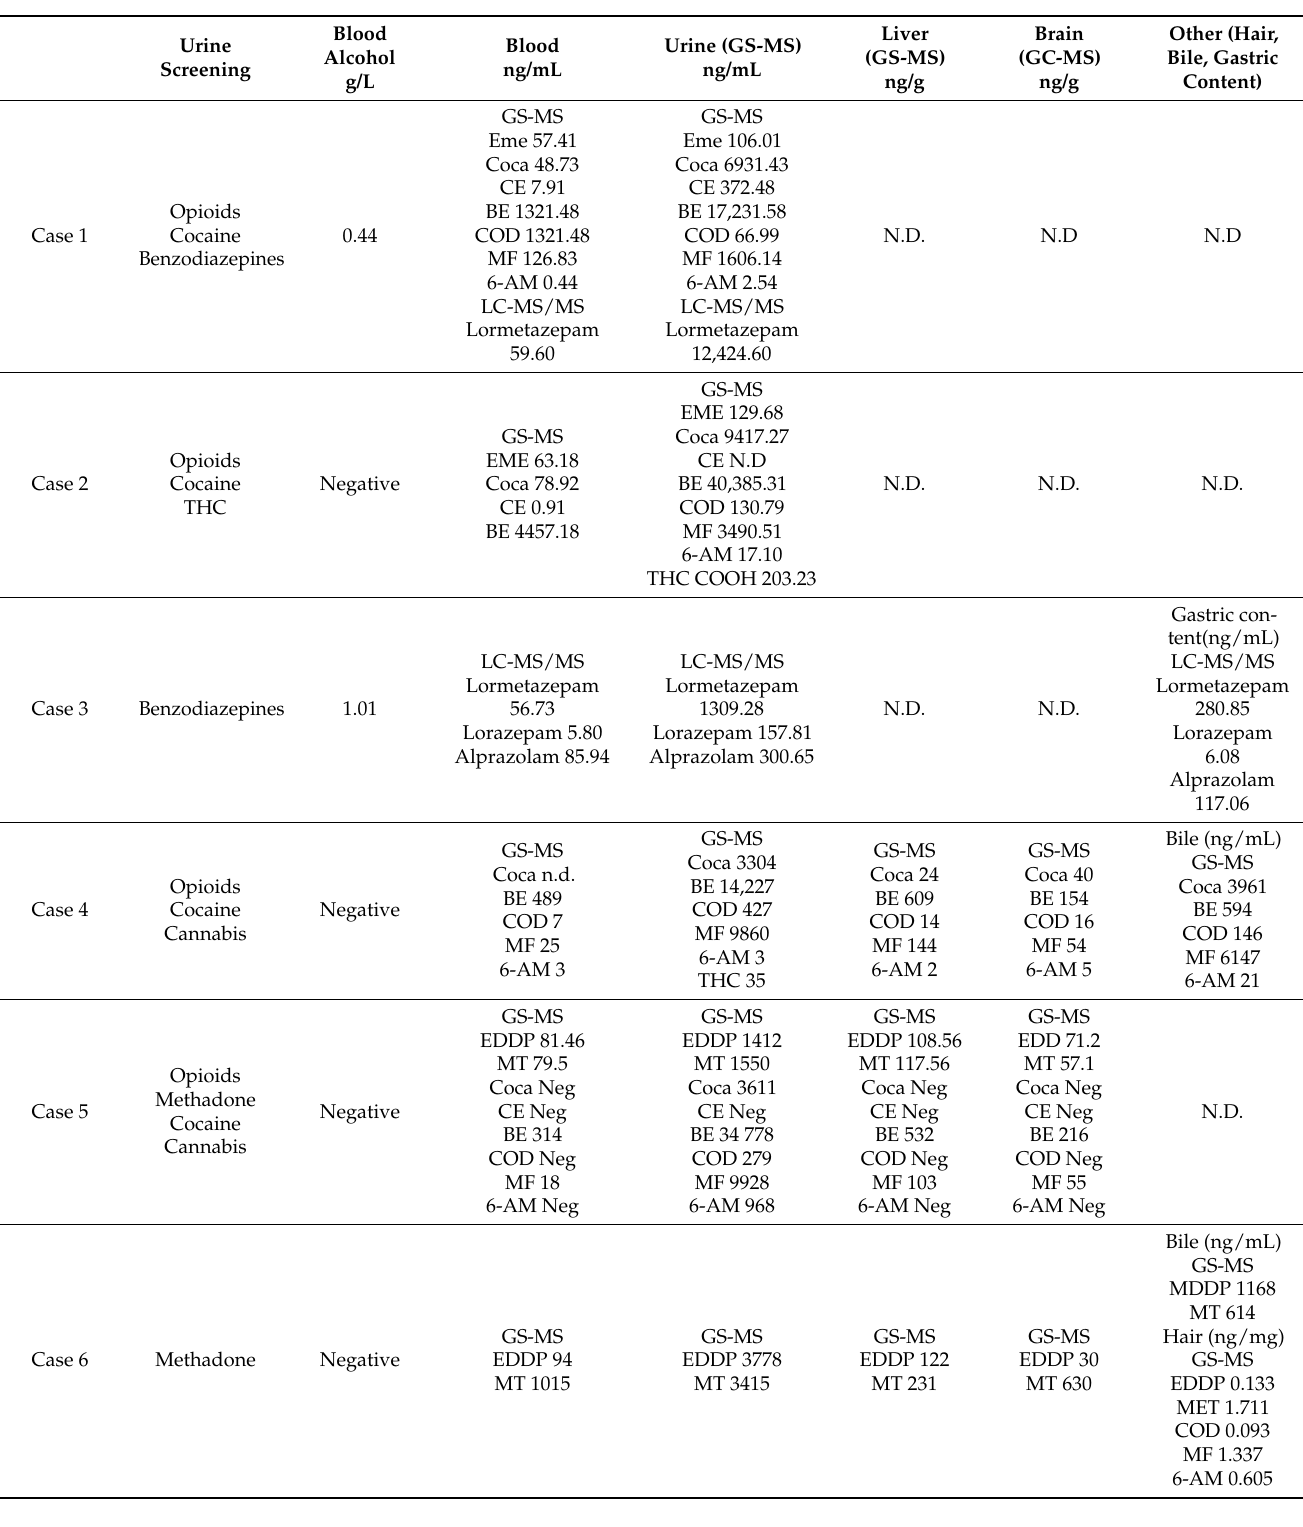
Table 2. A summary of toxicological analysis results Eme: ecgonine methyl ester; Coca: cocaine; CE: cocaethylene; BE: benzoyl ecgonine; COD: codeine; 6-AM: 6 acetyl-morphine; MF: morphine; THC: tetrahydrocannabino; MT: methadone; EDDP: Ethylidene-1,5-dimethyl-3,3-diphenylpyrrolidine; ND: not